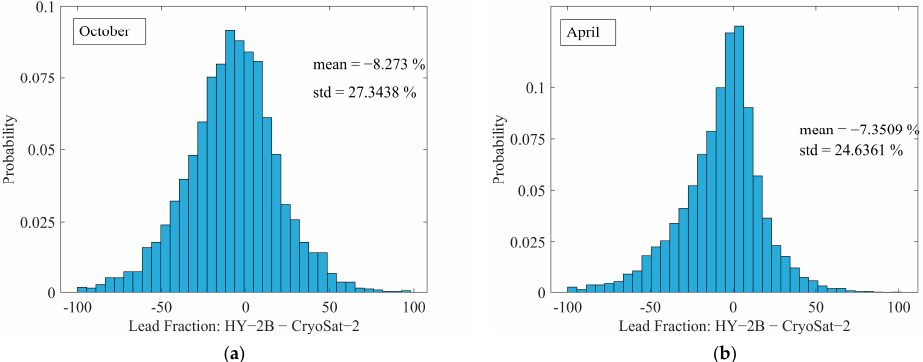
Figure 15. Histograms of bias for April and October 2019: ( a ) April; ( b ) October.